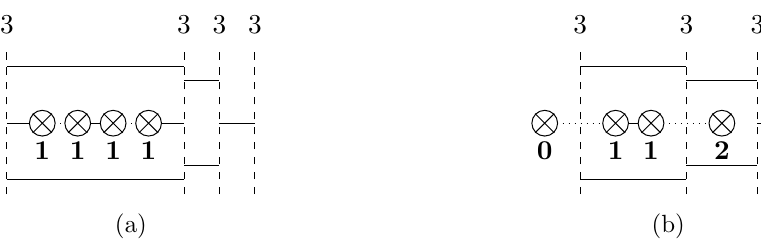
Figure 18. Brane realization of the D-collapse for the maximal nilpotent orbit of so (4). (a) Higgs branch brane con(cid:12)guration of the model with ~l d = (3 ; 3 ; 3 ; 3), ~l s = (1 ; 1 ; 1 ; 1) and rightmost orientifold plane O 3 (cid:0) before the collapse transition is performed. The interval numbers of the half NS5-branes are shown in bold font under the corresponding branes, they form the